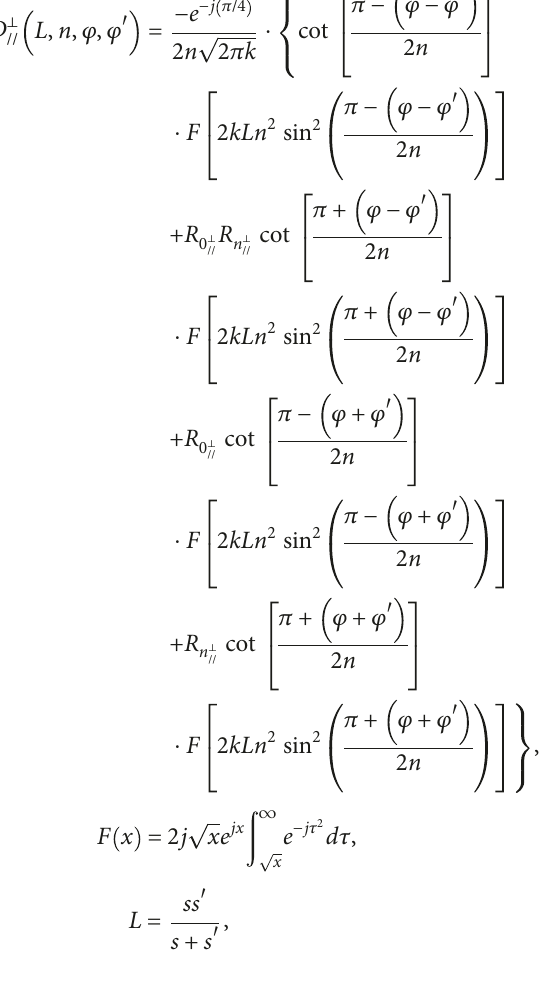
Figure 2: The demonstration of determining the next